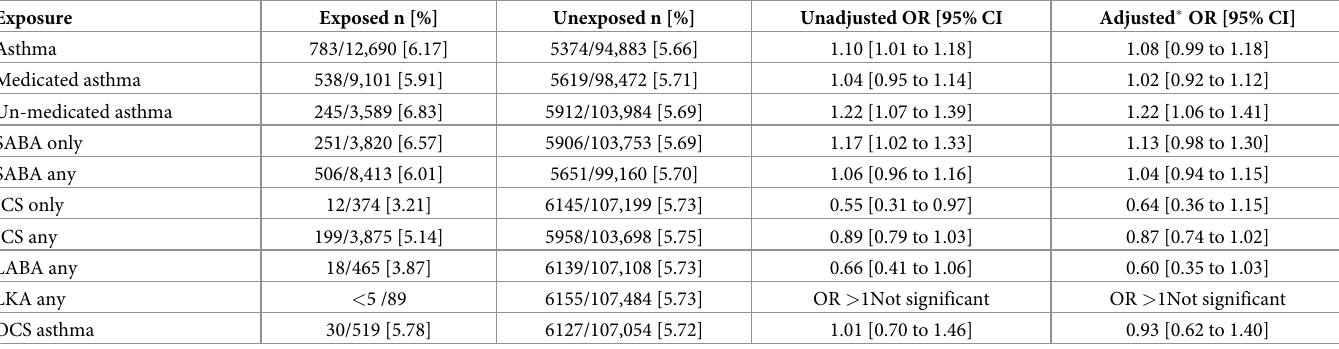
Table 2. Premature birth < 37 weeks (n = 107,573).